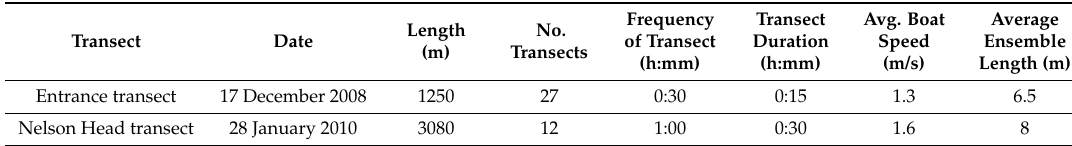
Table 2. Summary of ADCP transect